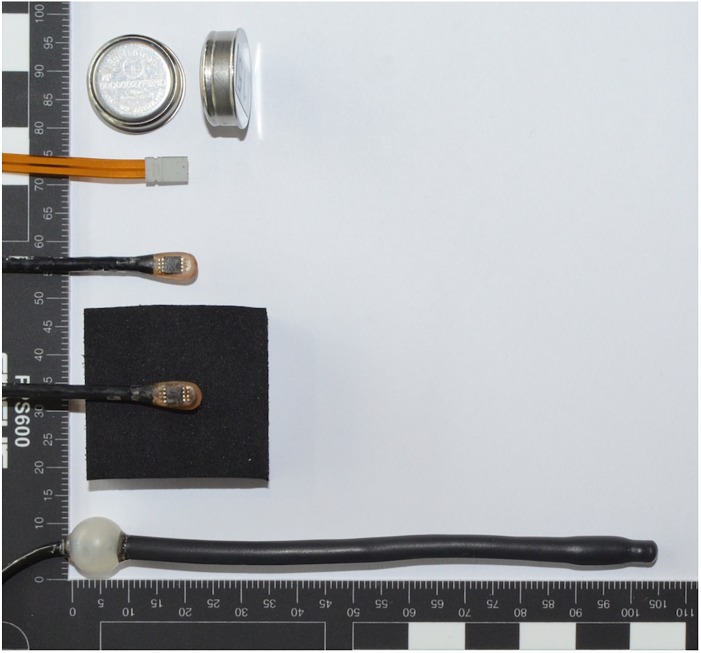
Temperature and heat flux sensors used in the study (scale in mm). From top down: iButton, heat flux sensor, non-insulated temperature sensor, insulated temperature sensor (side in contact with the skin is facing upward), and rectal temperature sensor.